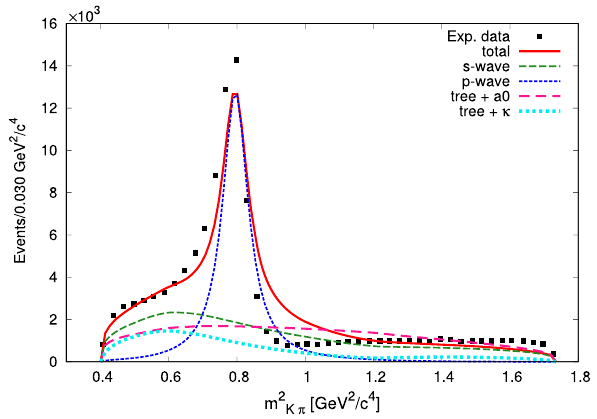
Fig. 10 M K η distribution Table 1 Values of the parameters from the fit. An extra global factor 3 . 0 × 10 7 is applied to all distributions to compare with the number of events in the data (the different binning for the distributions is considered when comparing to the data)